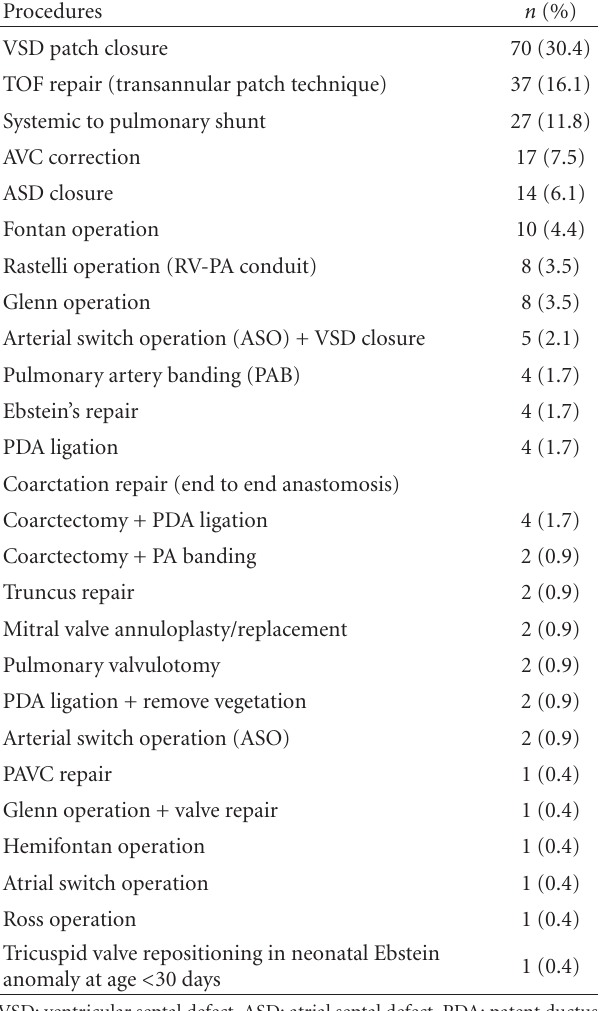
Table 2: Surgical procedures in the present study ( n =